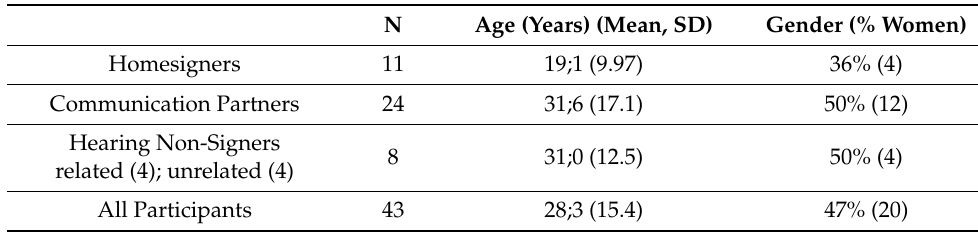
Table 2. Demographic